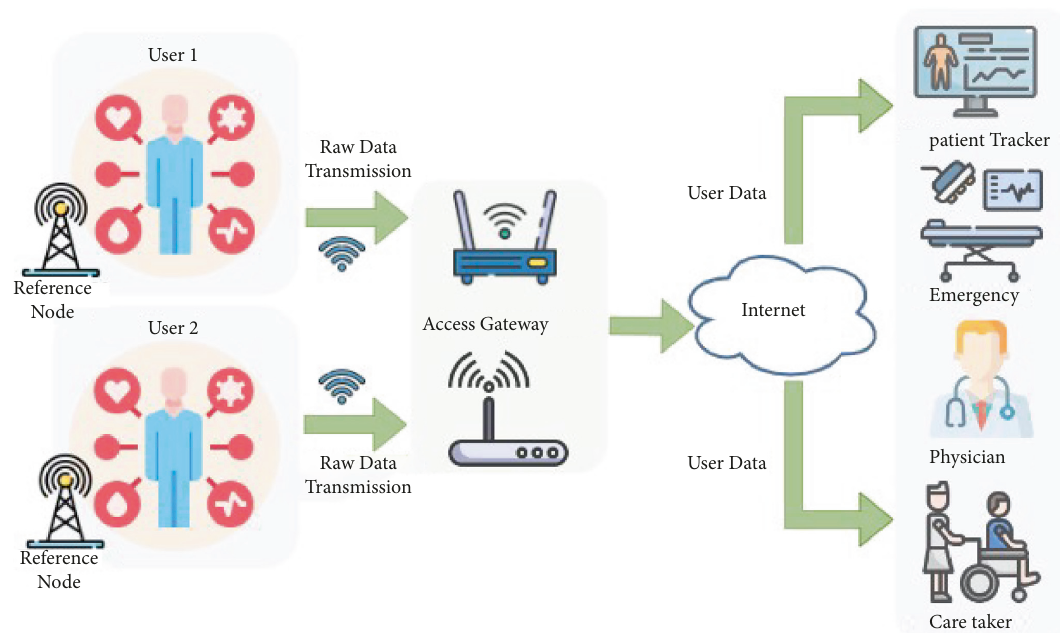
Figure 2: Architecture of the IoT healthcare system: an